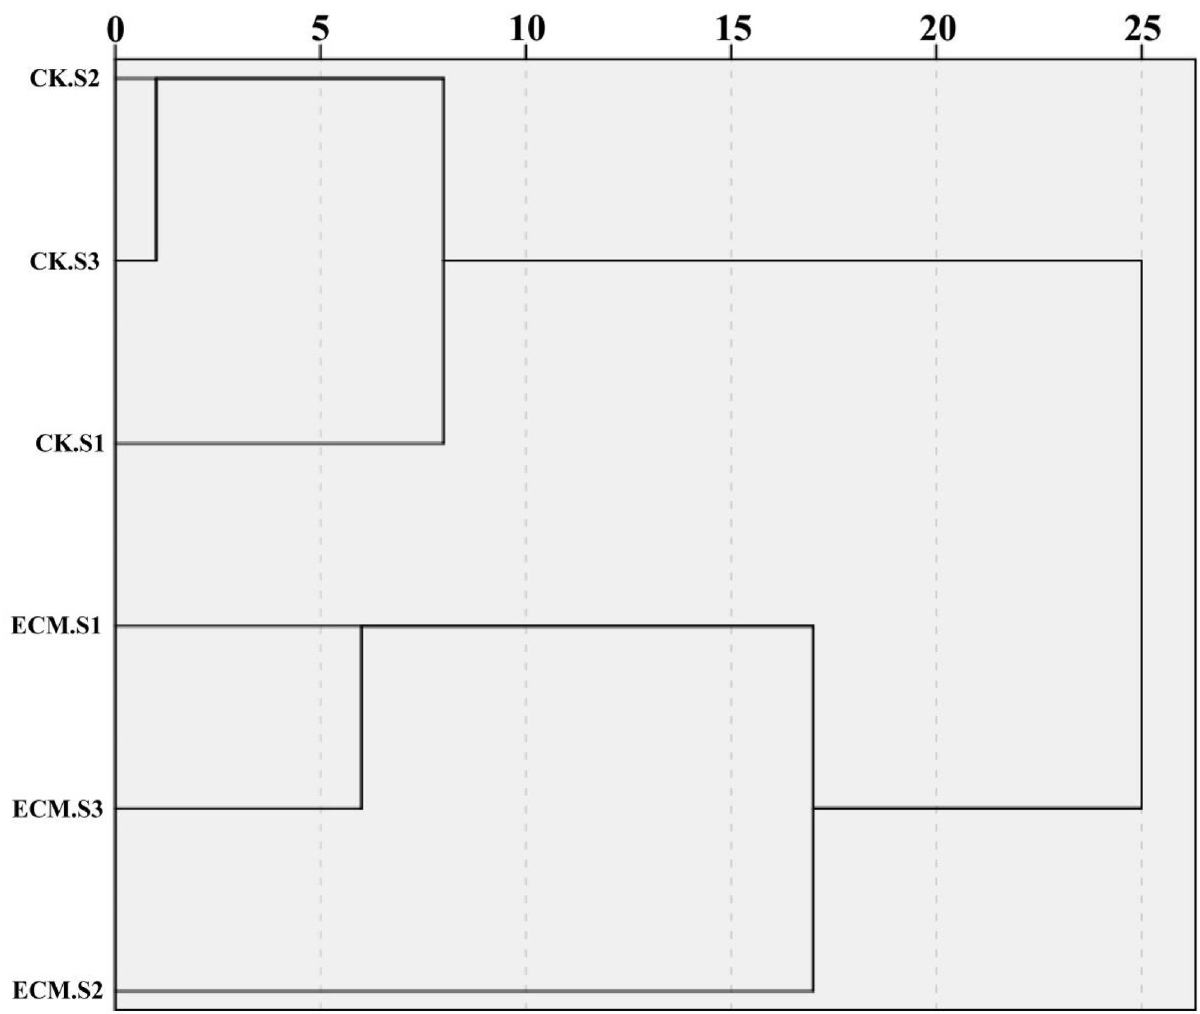
Fig 2. Hierarchical cluster analysis of the similarities among different samples based on the soil properties using the the between- groups linkage method in SPSS. CK.S, rhizospheresoil; ECM.S, ectomycorrhizospheresoil.